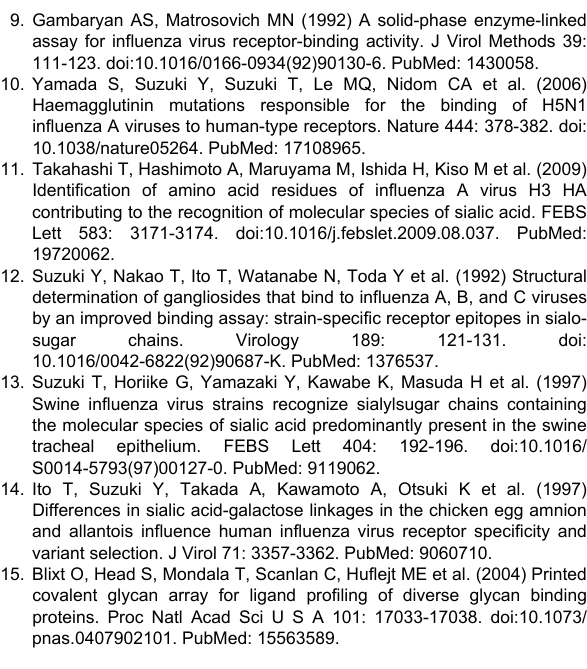
Figure S1. Structure of PGAs. PGAs have an LacNAc chain, the terminal of which binds with Neu5Ac by α2,3 linkage (A) or α2,6 linkage (B).